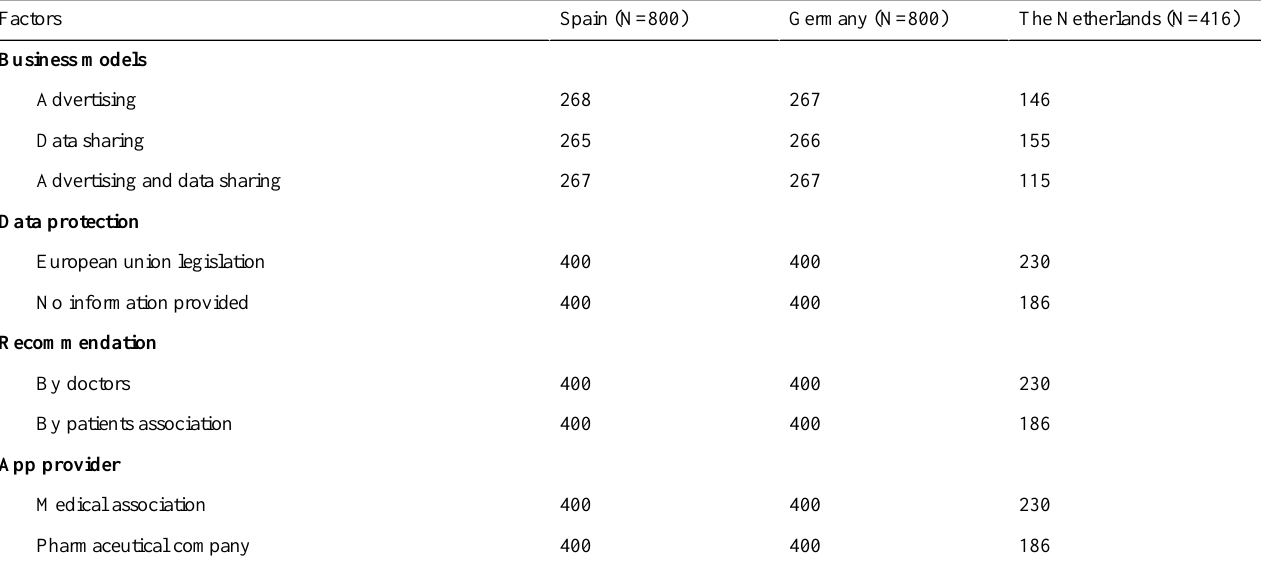
Table 1. Number of participants per condition for Spain, Germany, and the